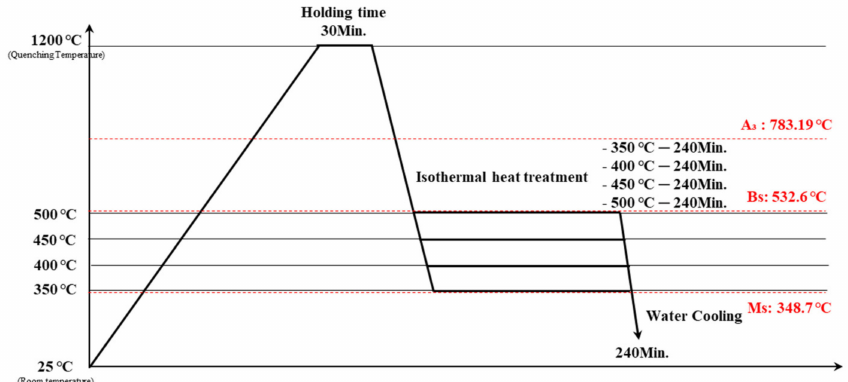
Figure 1. Schematic of the isothermal heat-treatment